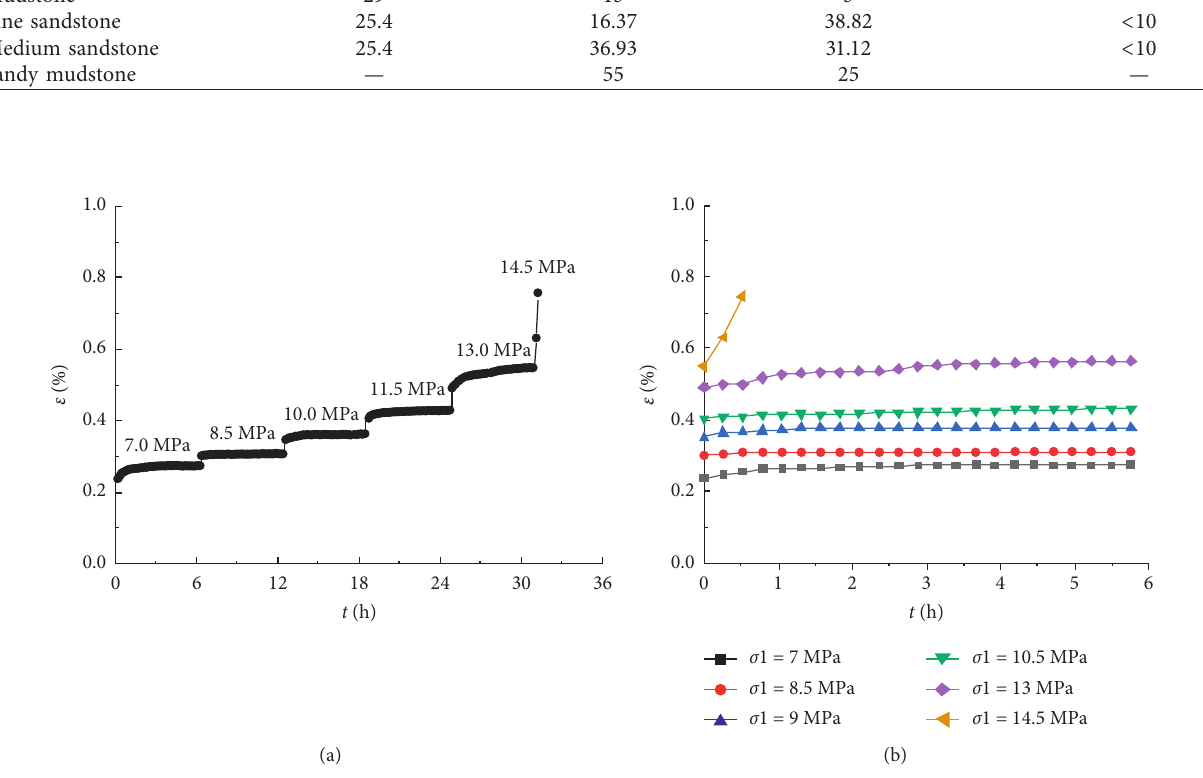
Figure 1: Under 1.5MPa confining pressure, (a) time-history curve of strain and (b) creep characteristic curve.